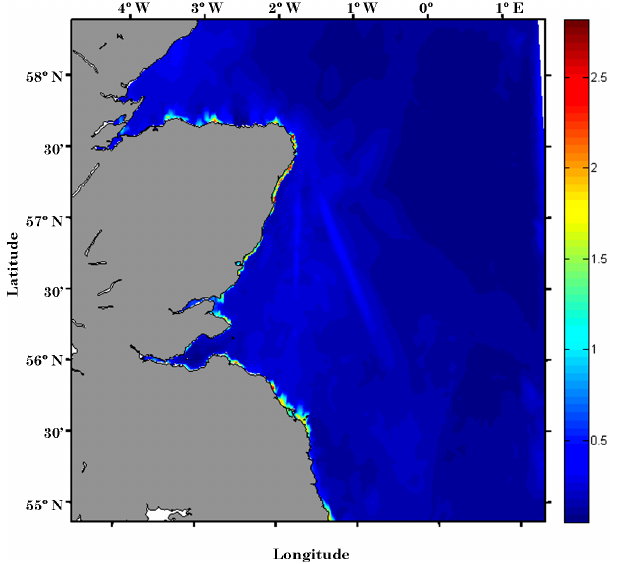
Figure 6. Maximum modelled negative deviation of the H s (m) due to the WCIs recorded in the 7-month period run in